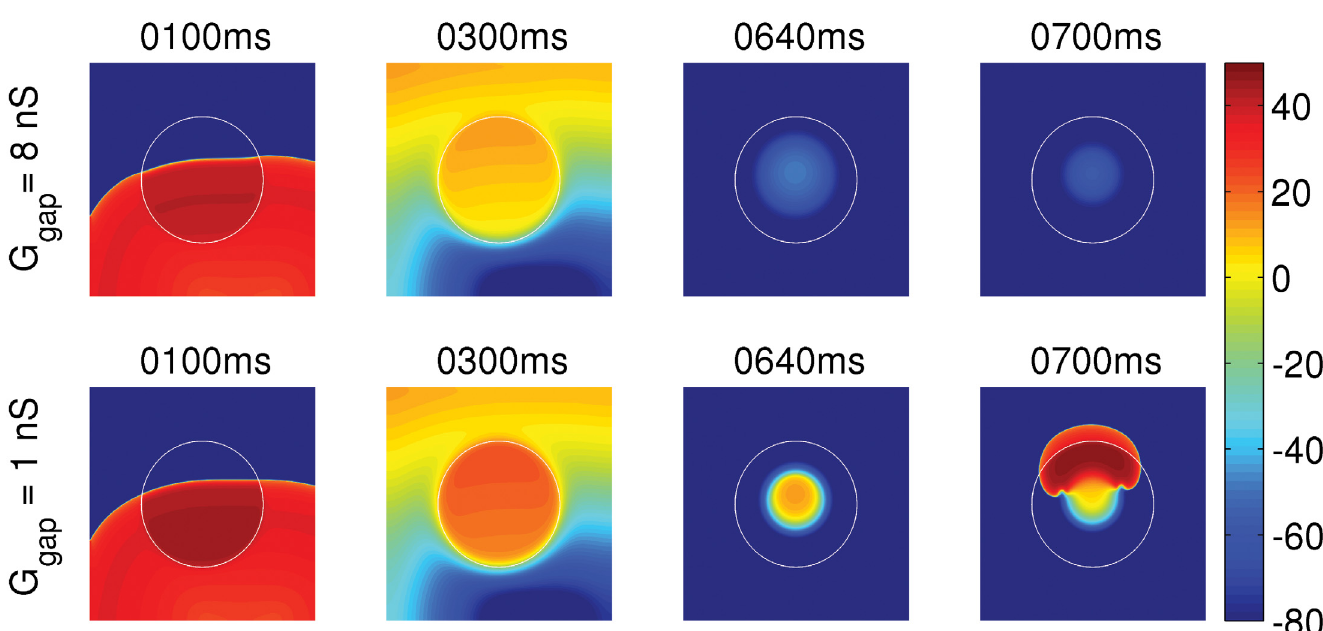
Fig 10. The dependence of PVC triggering on G gap . Pseudocolor plots of V m showing that the EAD clump, with radius R = 2.4 cm, loses its ability to trigger PVCs when coupled to fibroblasts of E f = -35 mV and G gap = 8 nS (top panel), but retains its ability to trigger PVC, if G gap is reduced to 1 nS (bottom panel).